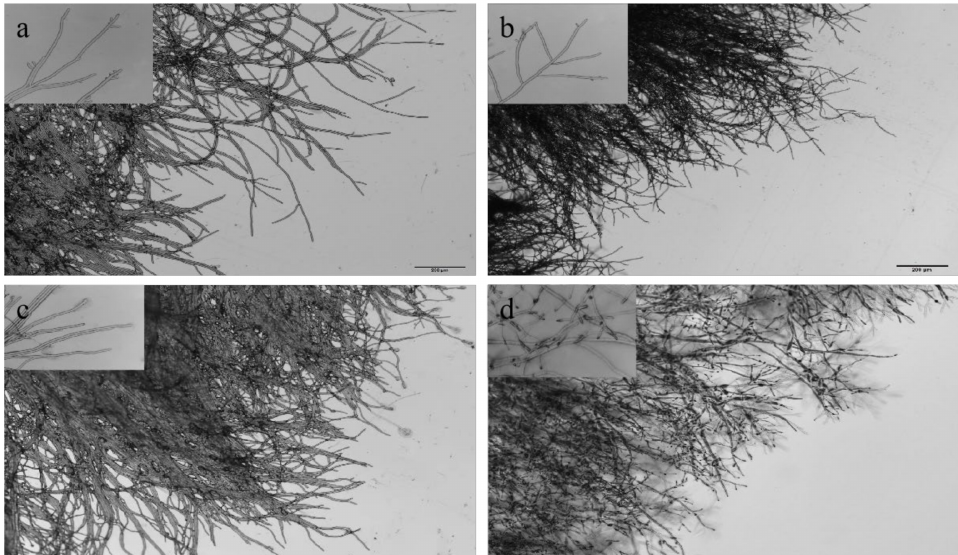
Figure 3. Effects of wuyiencin and ε -PL on the mycelial morphology of Botrytis cinerea under a microscope at 10 × magnification. ( a ): Morphology after 72 h of treatment with distilled wa- ter. ( b ): Morphology after 72 h of treatment with 500 µ g/mL ε -PL. ( c ): Morphology after 72 h of treatment with 25 µ g/mL wuyiencin. ( d ): Morphology after 72 h of treatment with 500 µ g/mL ε -PL + 25 µ g/mL